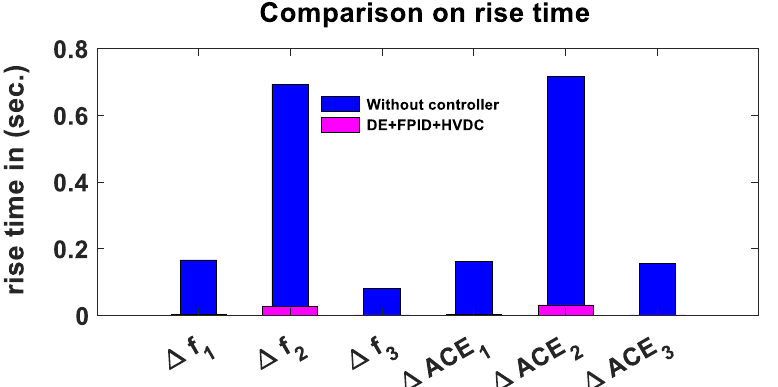
Figure 15. Comparison of controller and without controller for rise time for frequency deviation and area control error.